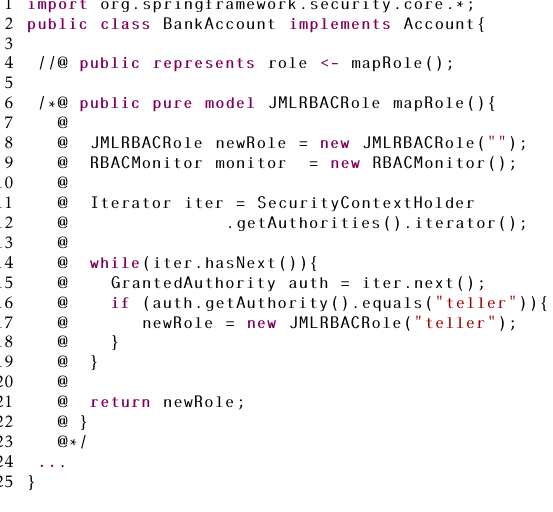
Figure 8. AnExcerptShowinga JML Abstraction Function. such contracts manually and eliminating a potential source for